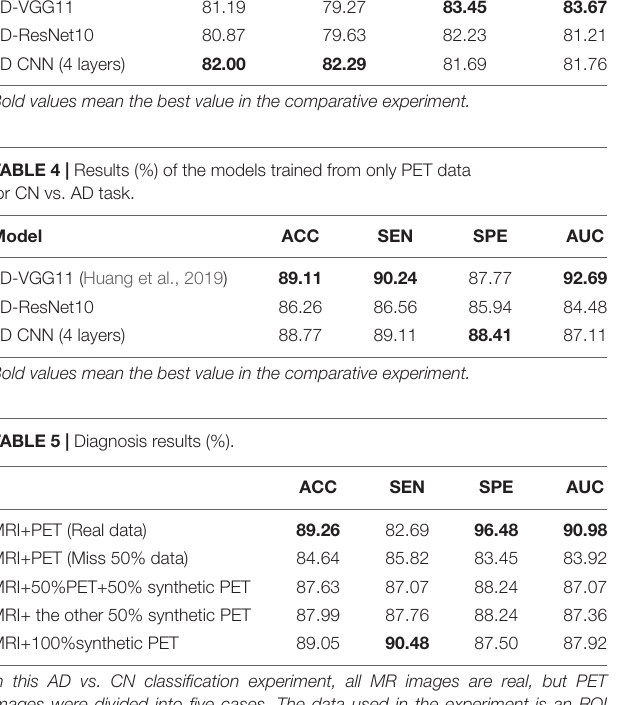
TABLE 3 | Results (%) of the models trained from only MRI data for CN vs. AD task. Model ACC SEN SPE AUC